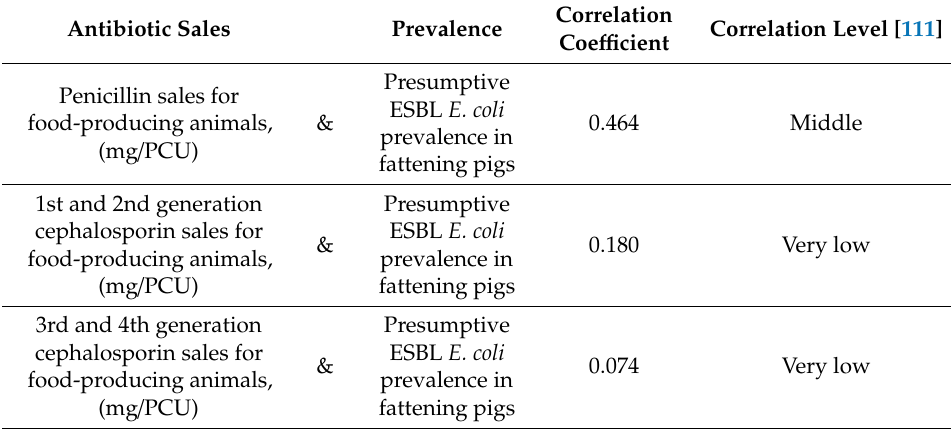
Table 4. Correlation between antibiotic sales and prevalence of presumptive ESBL-producing E. coli in fattening pigs, 2017.